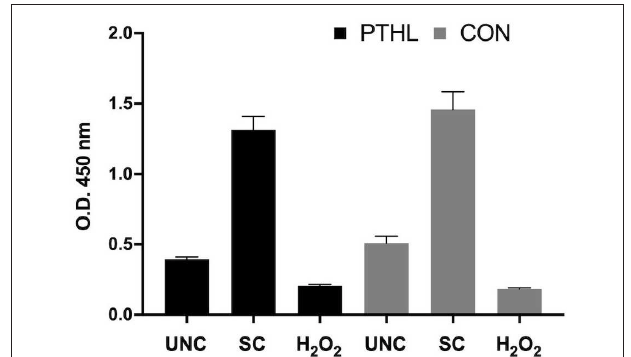
FIGURE 1 | BrdU incorporation in proliferating PBMCs isolated by blood of beef steers supplemented with Pinus taeda hydrolyzed lignin (PTHL) and with a control diet (CON). Cells were unstimulated (USC), stimulated with LPS and ConA (SC, 1 and 5 µ g/ml, respectively) and with 4mM of H 2 O 2 , and incubated for 24h at 37 ◦ C/5% CO 2